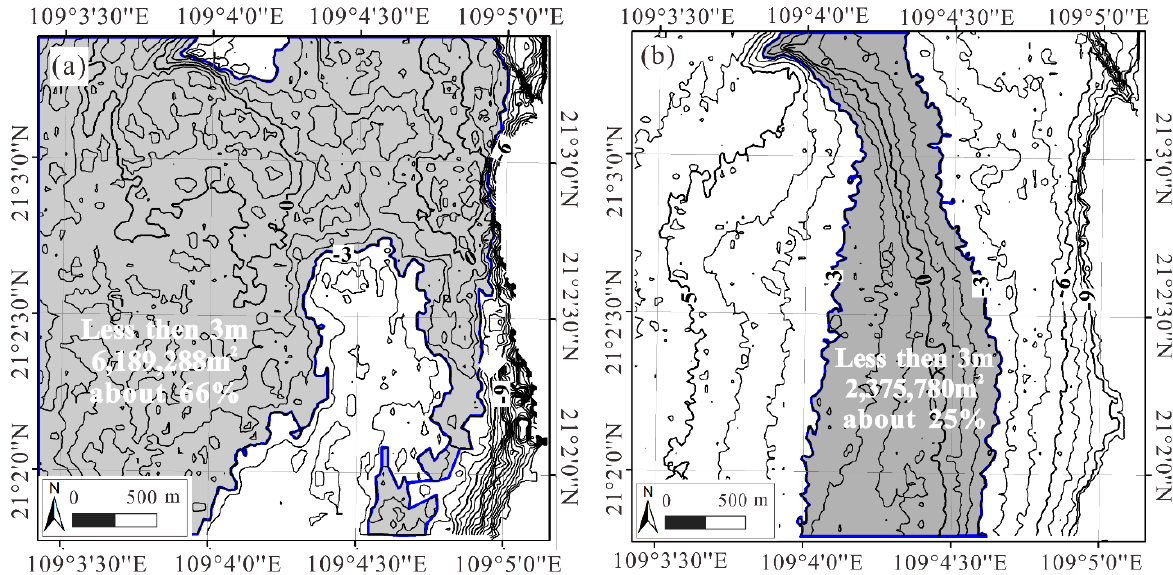
Figure 8. The error contours with our model ( a ), and with the traditional model ( b ).